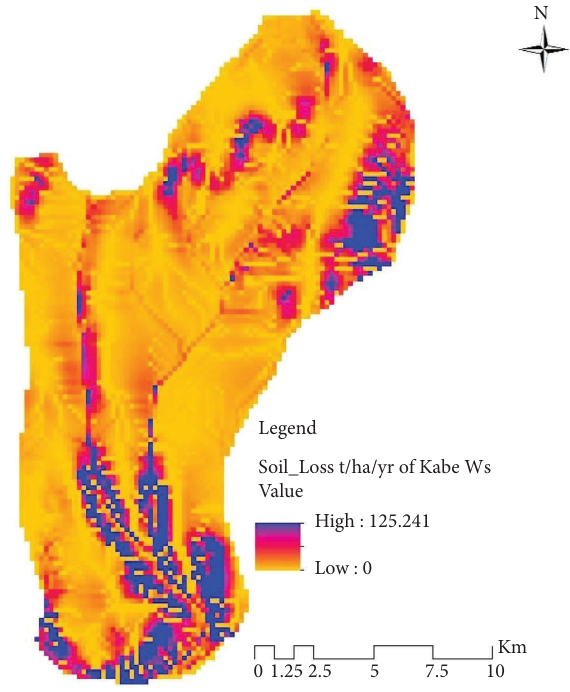
Figure 8: Te soil loss in the study